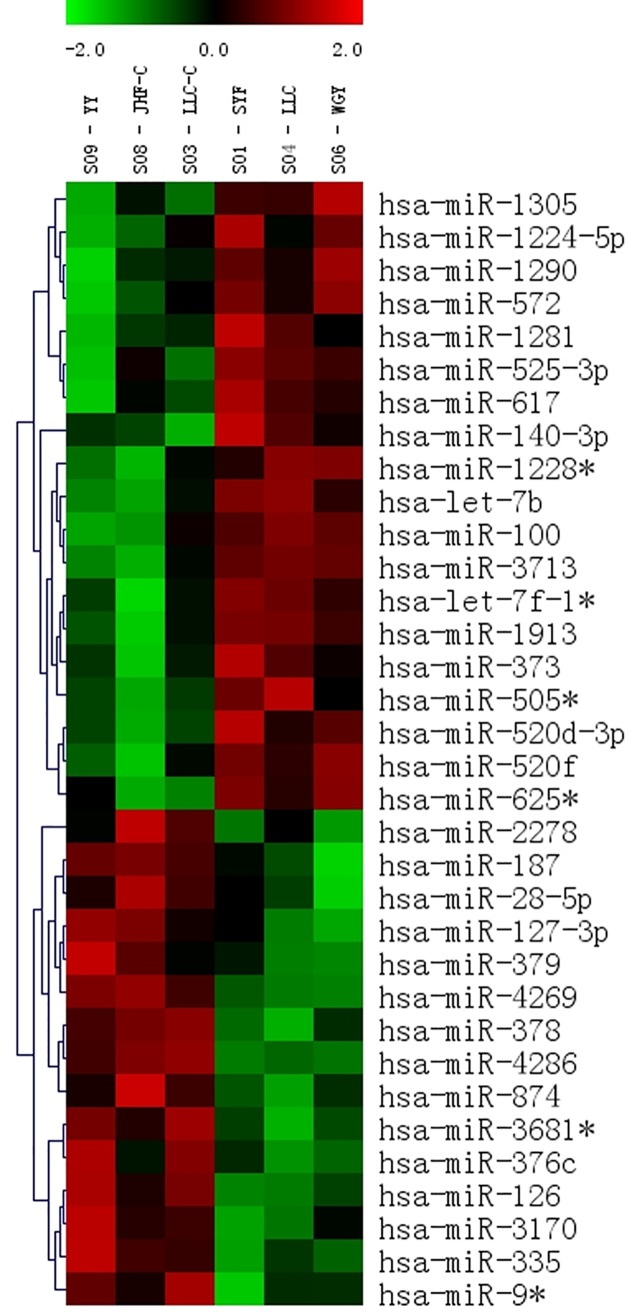
Heat map of differential miRNA expression in glioma and non-tumor tissues.Both down-regulated (red) and up-regulated (blue) miRNAs were identified in glioma tissues (N = 3) versus non-tumor tissues (N = 3).